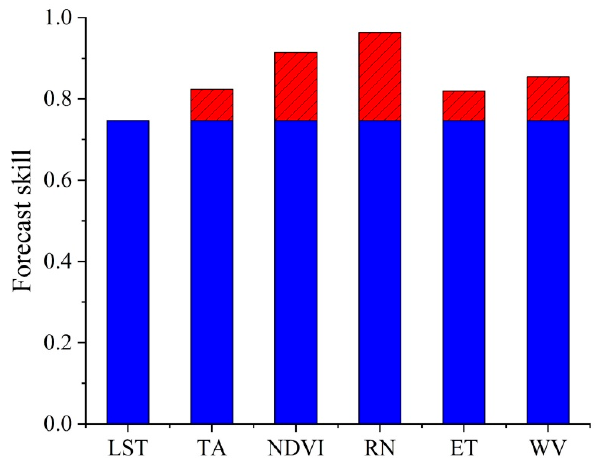
Figure 5. Multivariate EDM test between LST and environmental factors for the pixel selected from PMC region. The blue bars indicate the forecast skill of multivariate EDM before addition of environment factor and the red bars indicate the improvement of the forecast skill after the addition of environment factor.